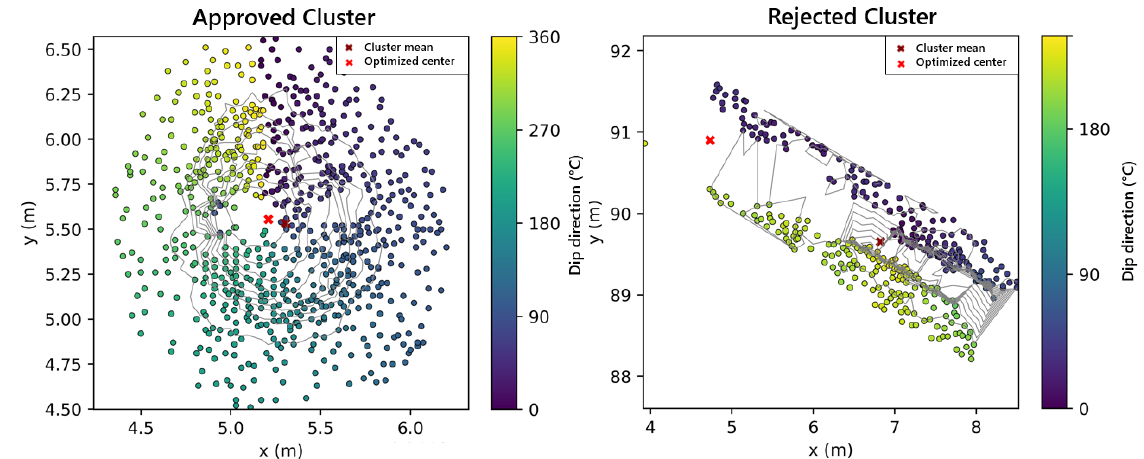
Figure 5. The dip direction represents the direction of the slope. Since the termite mounds have a conical shape, this value should alter from 0 to 360 degrees around the centre of the mound. If the optimized centre is located > 0.75 m from the mean position of the cluster or if the RMSE of optimization > 1, the cluster is rejected. The grey lines are contour lines (height). In this figure, the approved cluster is a termite mound, while the rejected cluster is a fallen tree trunk. Taken from the UAV-LS (HR) data